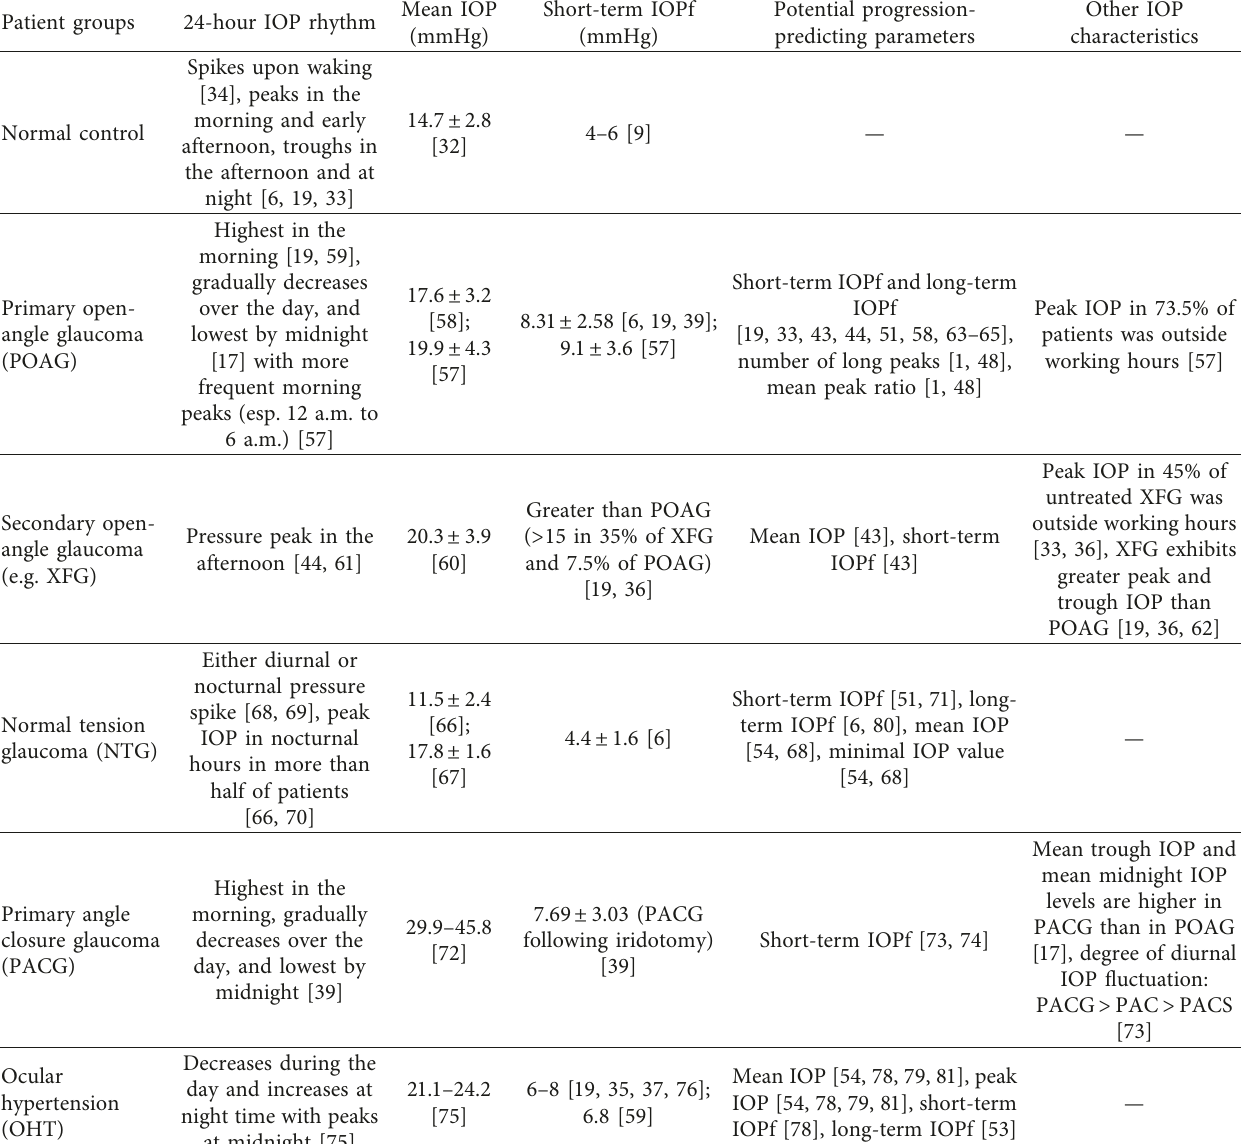
Table 1: Summary of 24-hour IOP patterns in normal individuals and different glaucoma types and the potential progression-predicting IOP parameters in different glaucoma